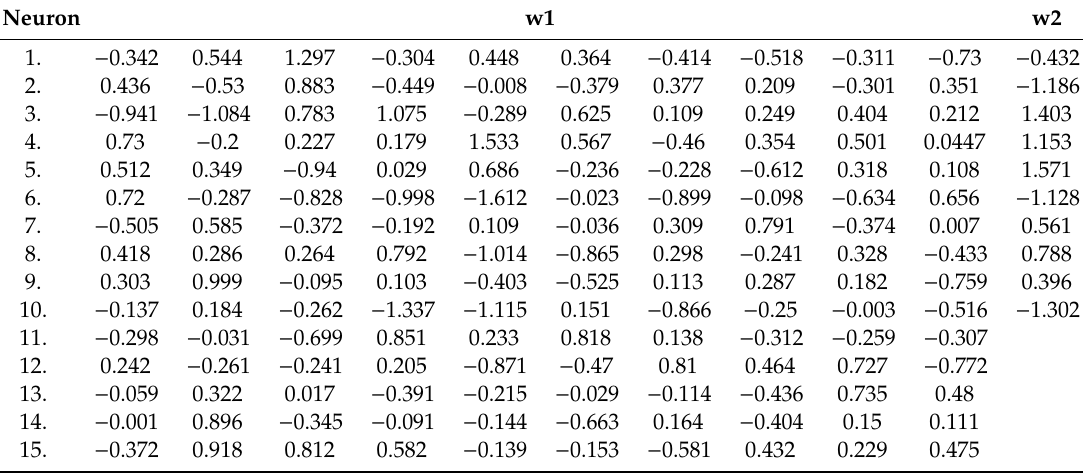
Table 15. Weights of hidden layers of developed